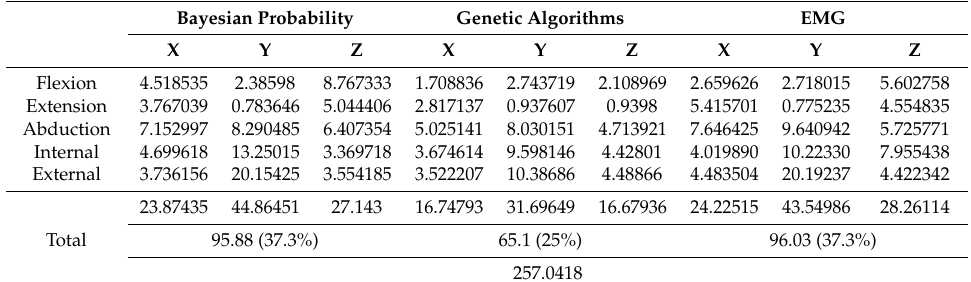
Table 2. Difference in the total sum of the difference of the original and estimated orientations.